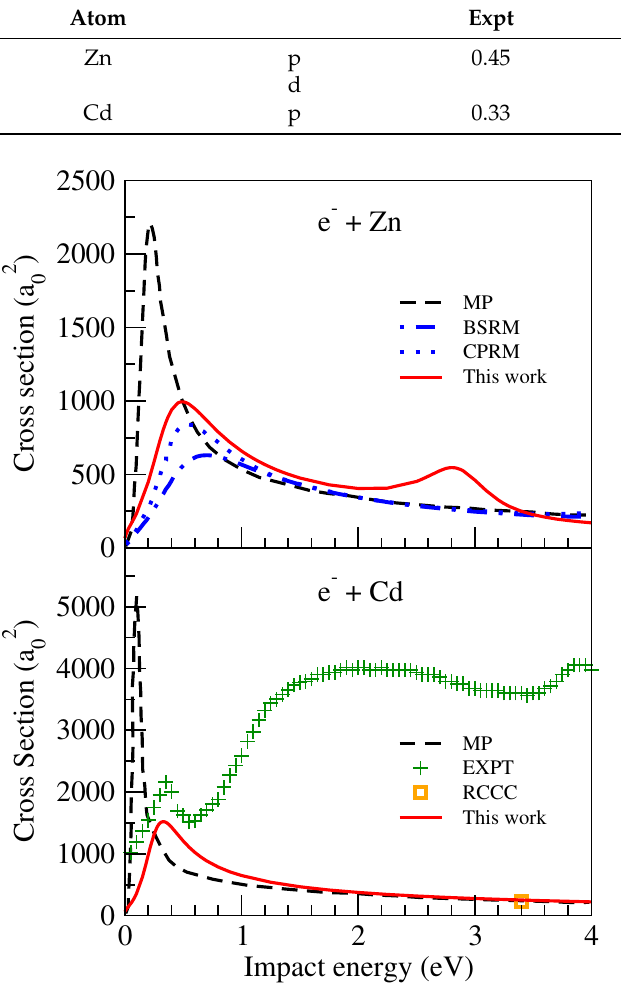
Figure 4. Elastic cross section for electron–Zn ( upper panel) and electron–Cd ( bottom panel). In both panels, the present results are given by the solid red line, and the MP calculation results of [8] are represented by the dashed black line. For Zn, the dotted blue line represents the CPRM calculation and the dashed blue line the BSRM results [11]. For Cd, the green crosses are the experimental data of Kontros et al. [6], and the yellow square is the ICS obtained by integration of the RCCC [12] DCS at 3.4